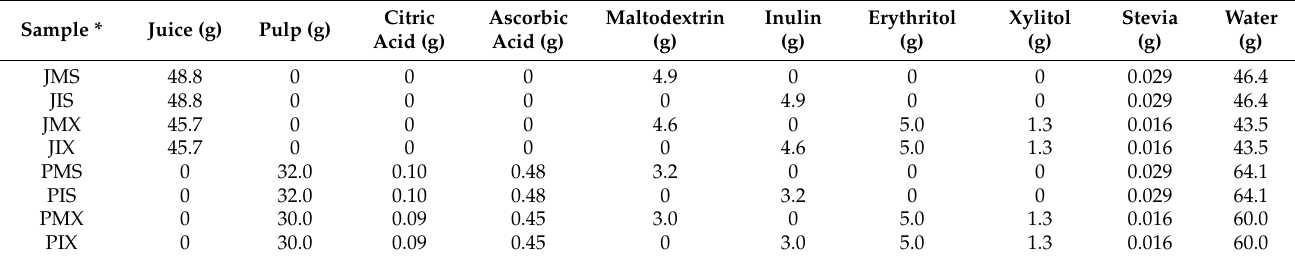
Table 1. Formulation of 100 g of lulo beverage before